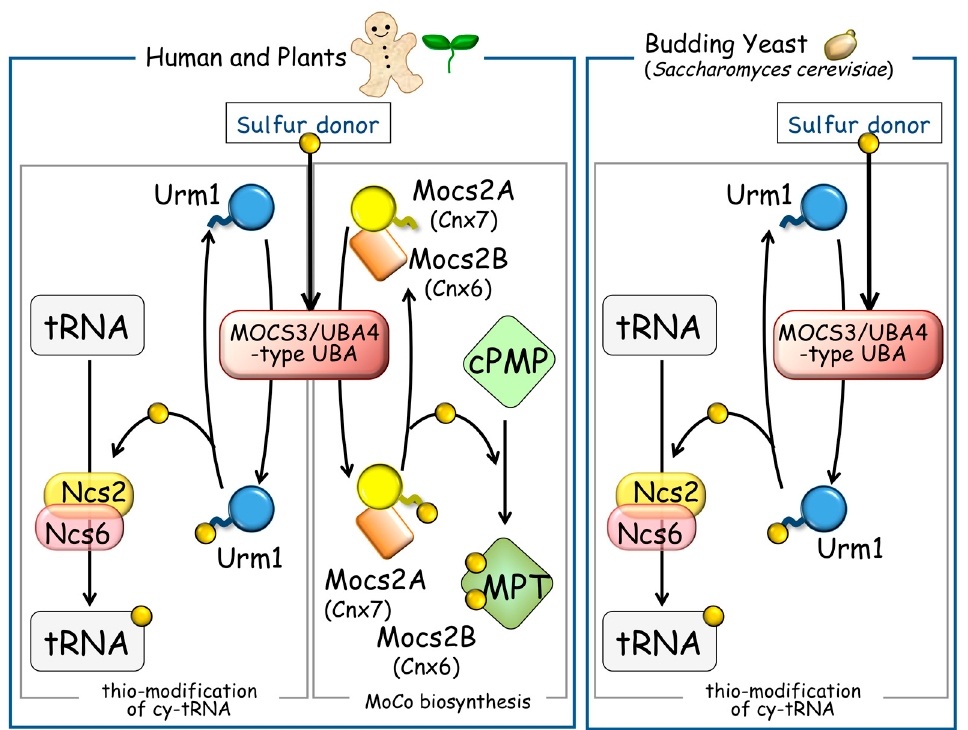
Figure 4. Sulfur delivery to the U 34 in cy-tRNAs and for molybdopterin (MPT) biosynthesis in eukaryotes. Multicellular eukaryotes (human and plant) possess two types of ubiquitin-like (UBL proteins, for MoCo biosynthesis, and for the thio-modification of tRNA, both of which associate with the common Uba4/MOCS3-type UBA proteins (left panel). On the other hand, the yeast Saccharomyces cerevisiae contains no MoCo biosynthesis-related proteins and only Urm1 for thio-modification of tRNAs associates to Uba4 (right panel). Sulfur atoms to be delivered are shown with filled circles.